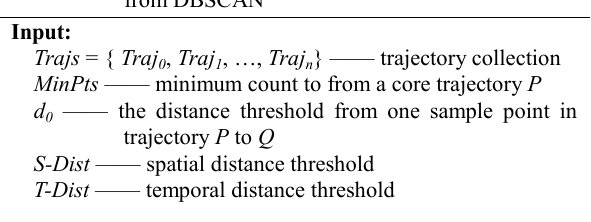
Algorithm: Trajectory spatiotemporal clustering extended